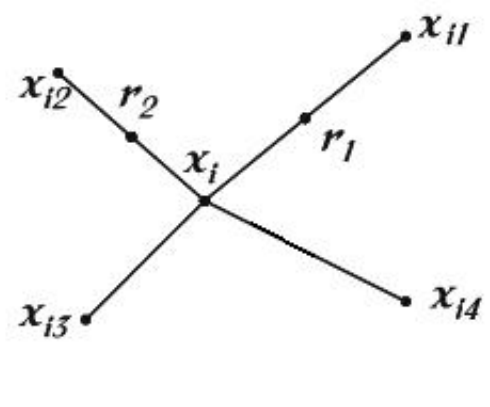
Figure 1: Creation of synthetic data points in the SMOTE